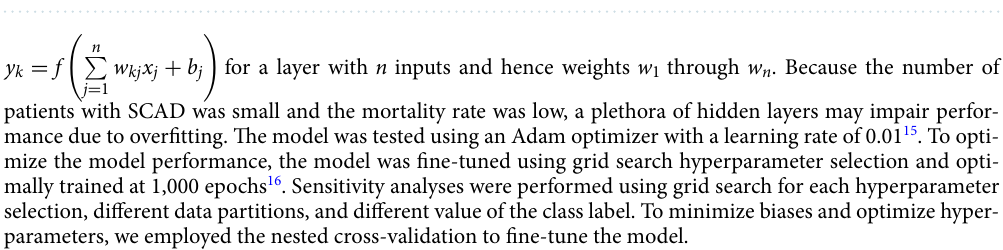
Figure 1. Machine learning and deep learning workflow process